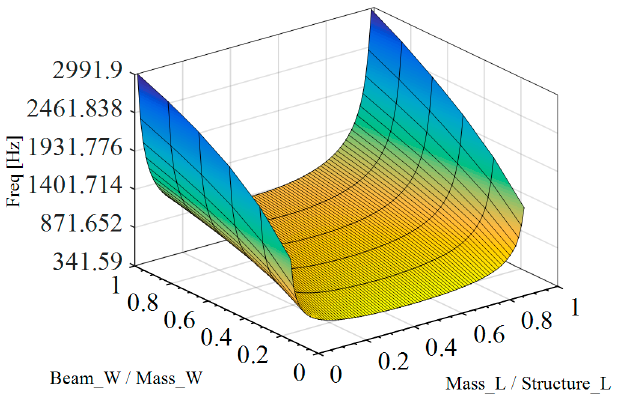
Figure 7. Effects of the variation of the Mass_L/Structure_L ratio on the value of the first Eigen frequency for different Beam_W/Mass_W ratios. Note that here the wafer substrate is used as a proof mass.